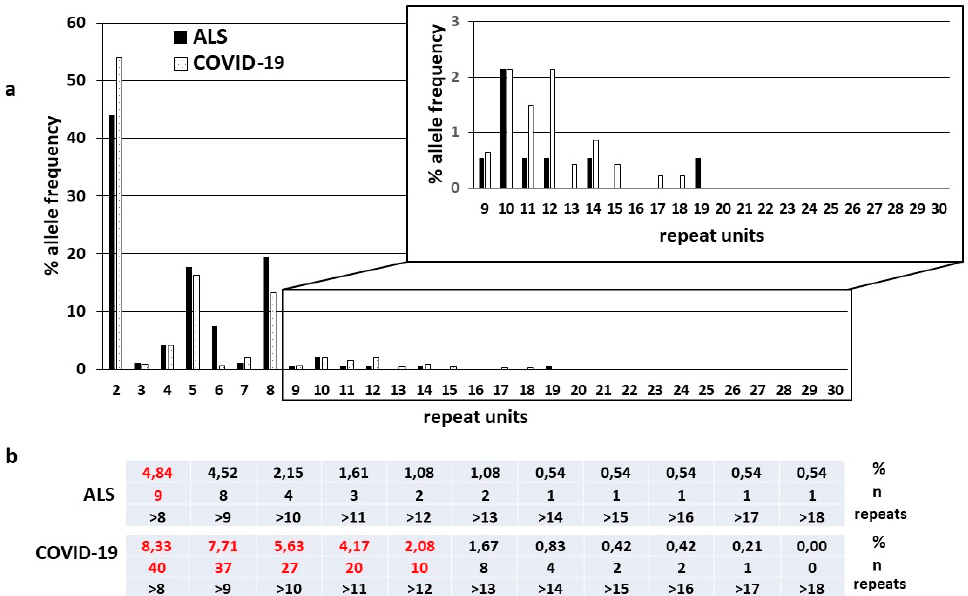
Figure 1. ( a ) Histogram showing the distribution and frequency (%) (Y-axis) of the number of C9orf72 hexanucleotide repeats (X-axis) in ALS (black bars) and COVID-19 (white bars) patients’ alleles. ( b ) Frequency (%) and number ( n ) of intermediate alleles for each repeat length >8 repeat units in ALS and COVID-19 patients. Both for ALS and COVID-19 patients, the % and n for repeat length > 8 units are in red; for COVID-19 patients, % and n with a clear difference in comparison with ALS patients are also highlighted in red.